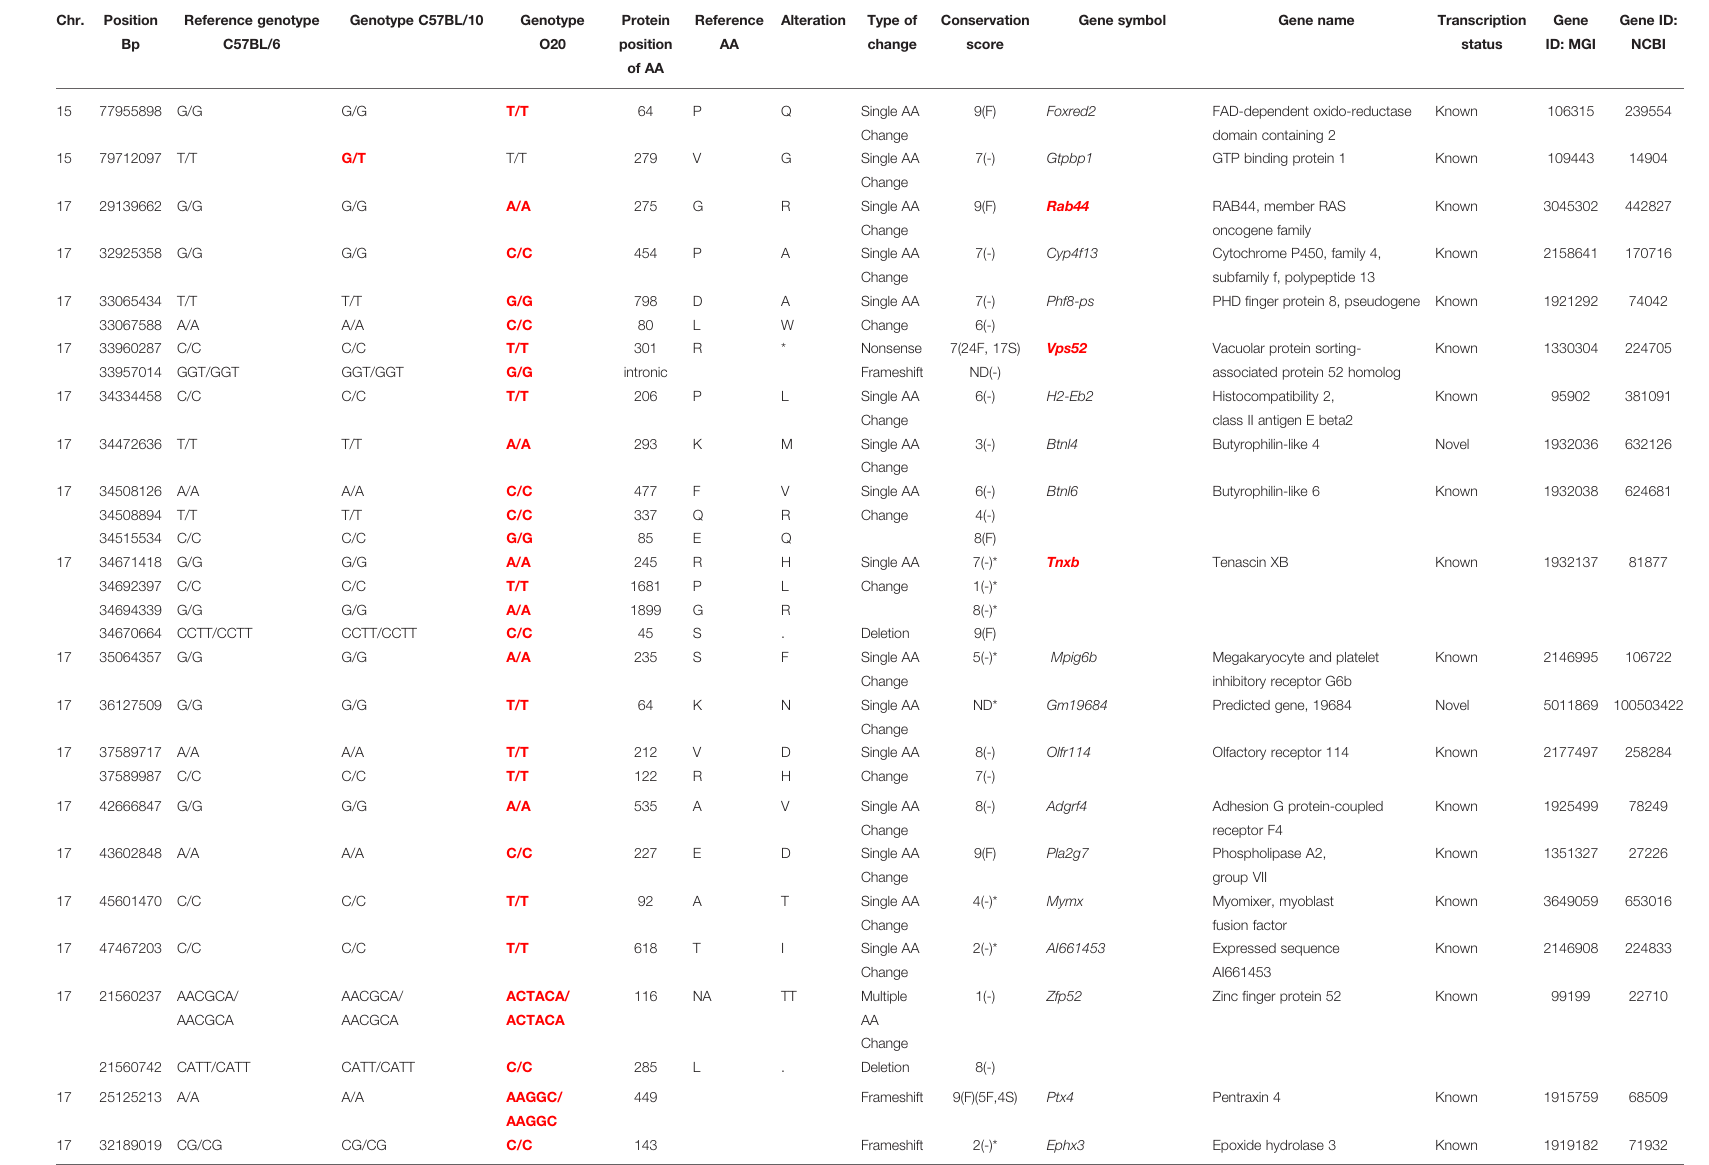
TABLE 5 | List of candidate genes controlling cell subpopulation frequencies in strain B10.O20. Chr. Position